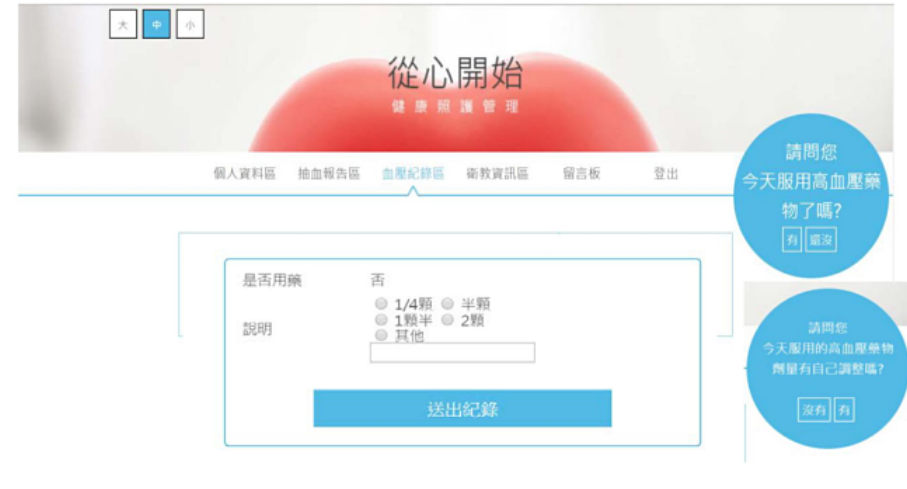
Figure 1. Screenshot of instruction in self-titration strategy.